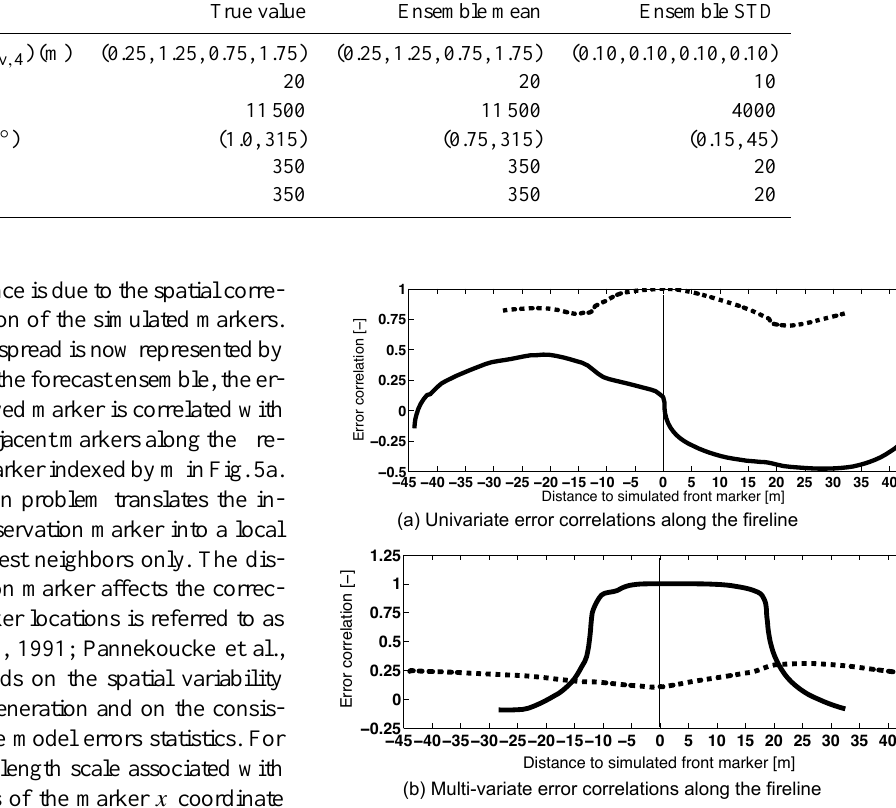
Figure 6. See caption of Fig. 4. OSSE anisotropic case with un- certain ROS model parameters and with uncertain ignition location ( x ign , y ign ) at the observation time t = 150s; the vertical bar repre- sents its reference location indexed by m in Fig.